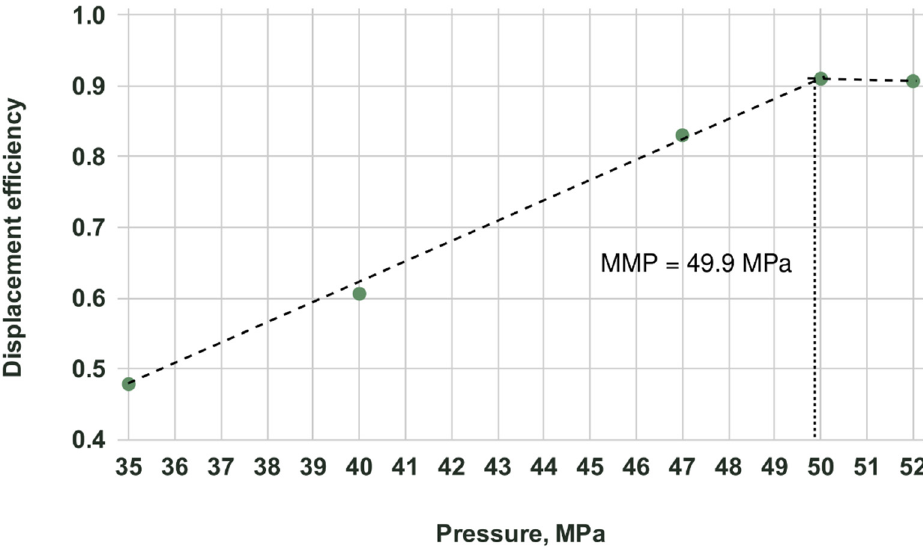
Figure 2. Minimum miscibility pressure for methane displacement.